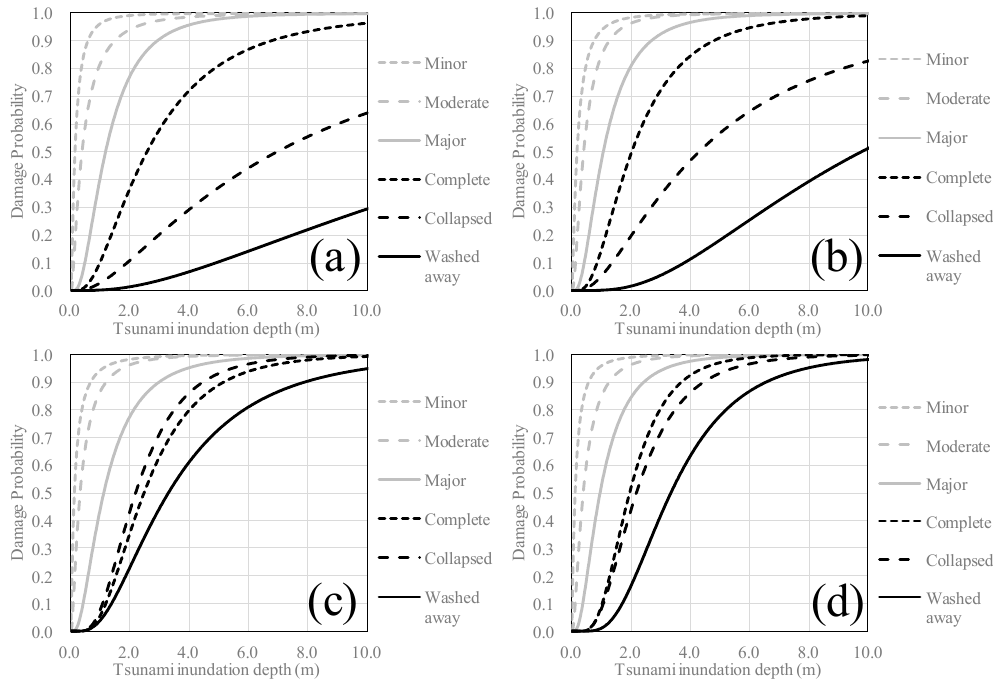
Figure 13. Tsunami fragility curves for different building structures (( a ) Reinforced concrete; ( b ) Steel; ( c ) Brick and ( d ) Wood) and different damage levels, which were created by regressing the damage data from the 3.11 Tohoku earthquake [20].